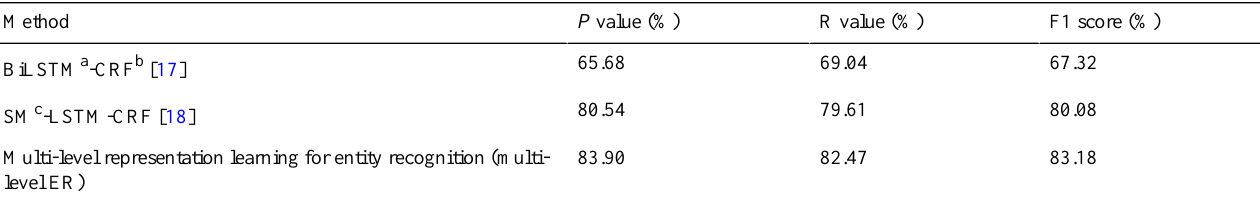
Table 4. Comparison of method performance on the China Conference on Knowledge Graph and Semantic Computing 2018 dataset.